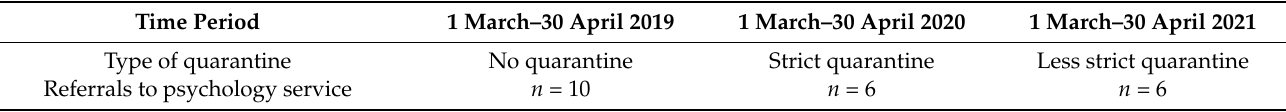
Table 1. Number of referrals across different time